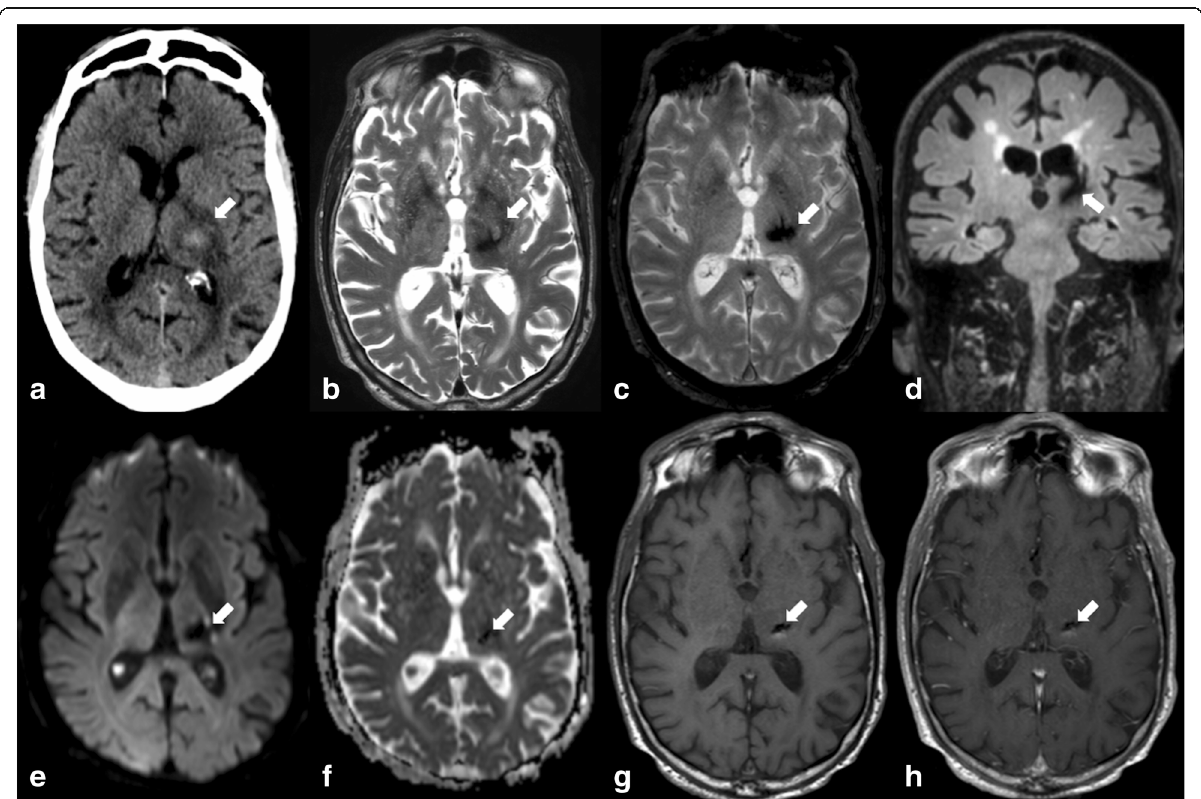
Fig. 9 There is a hyperdense lesion on non-contrast surrounded by oedema (arrow in a ). Follow-up MRI shows resolution of the oedema and low signal intensity of the lesion on all sequences including T2 ( b ), T2* ( c ), FLAIR ( d ), DWI b1000 ( e ), ADC map ( f ), non-contrast T1 ( g ), and T1 post contrast ( h ) reflecting the expected progression of a subacute into chronic haematoma in a patient with